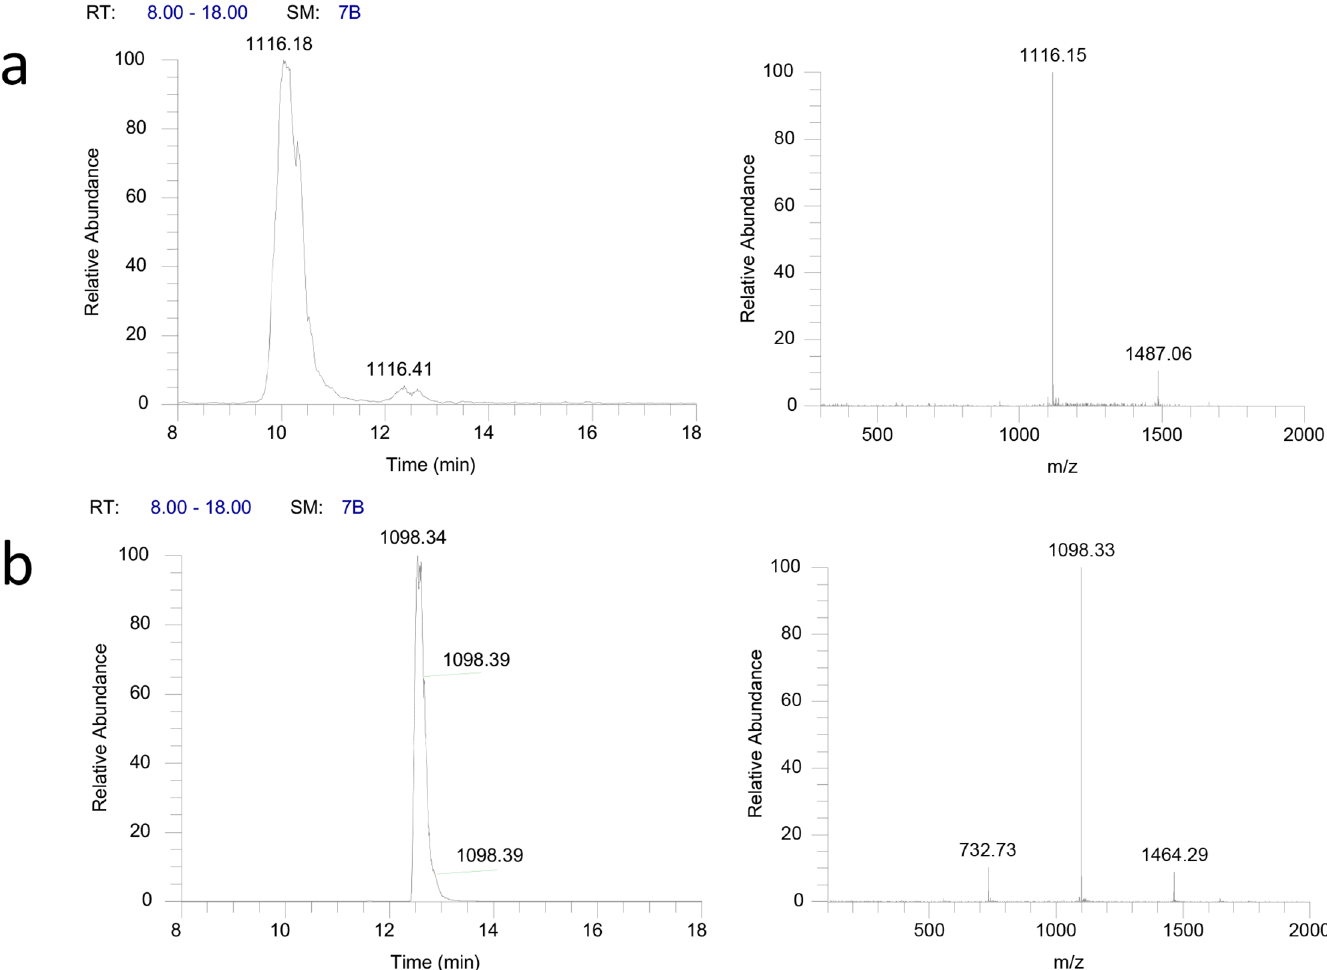
Fig 4. LC-MS analysis of the metabolites produced by mutants. (A) The doubly charged ions for ramoplanin A2 aglycone (m/z 1116) produced by A . CJS1001 ; (B) The doubly charged ions for deschlororamoplanin A2 aglycone (m/z 1098) produced by A . CSL1015 . The left panel shows the base peak corresponding to the compounds while the right panel indicates the